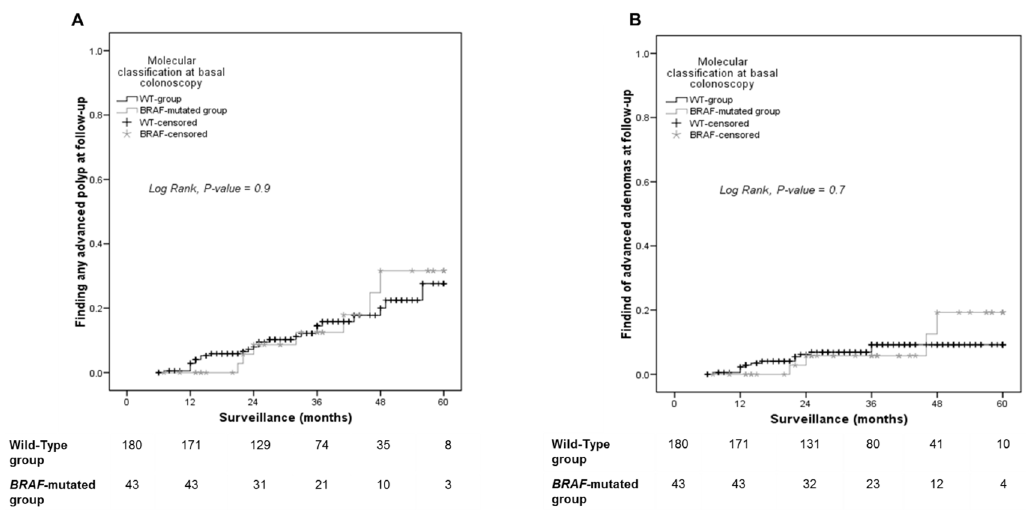
Fig 1. Risk of developing advanced polyps based on BRAF mutational status at baseline colonoscopy. Kaplan- Meier curves show the proportions of patients with WT or BRAF -mutated lesionsthat developed either (A) any advancedpolyp or (B) advancedadenomaover time.